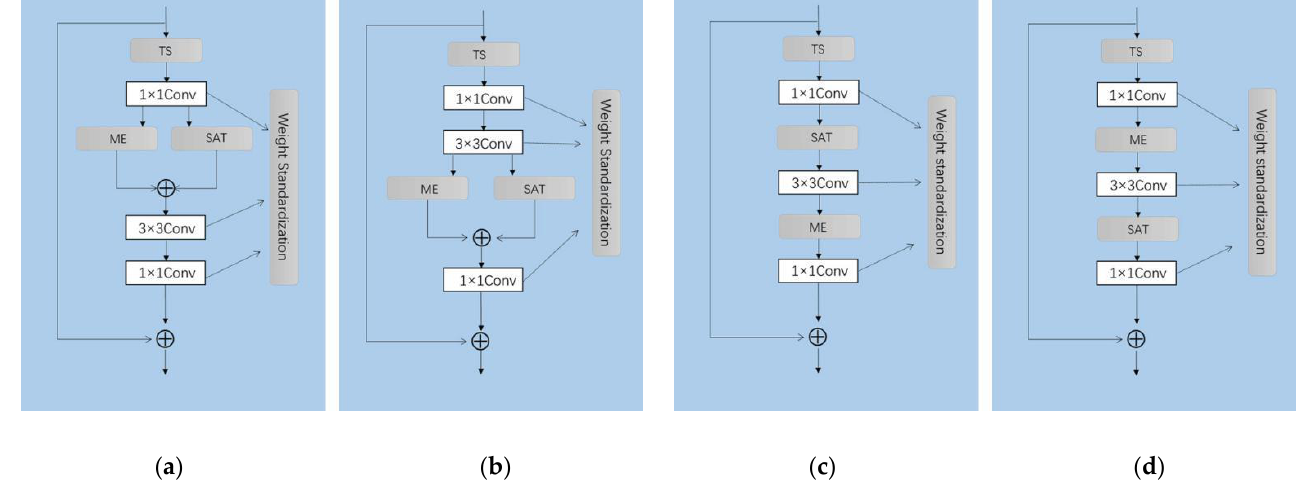
Figure 7. Different layouts of integrating the proposed 2 modules. ( a ) Mode 1; ( b ) Mode 2; ( c ) Mode 3; ( d ) Mode